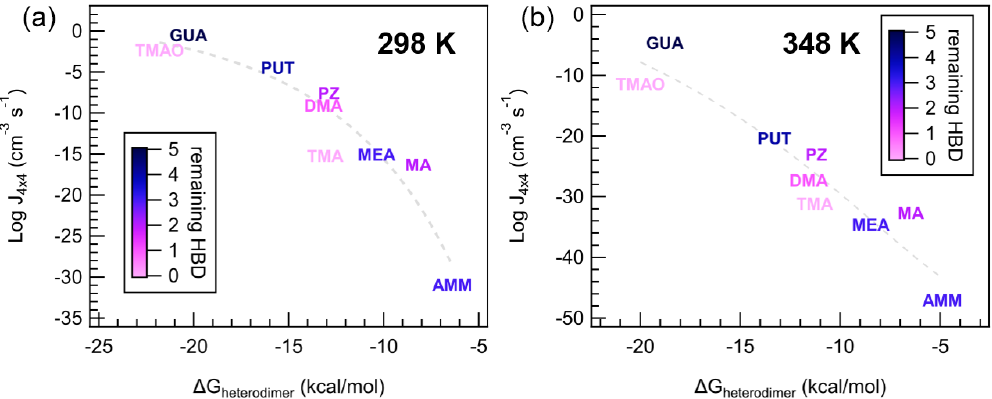
Figure 9. Individual data points and trendlines from Fig. 8a colored according to the number of remaining hydrogen bond donors (HBDs) on the heterodimer. Panel (a) indicates data from the 298K case and (b) indicates data from the 348K case, at [acid] = [base] = 10 6 moleccm − 3